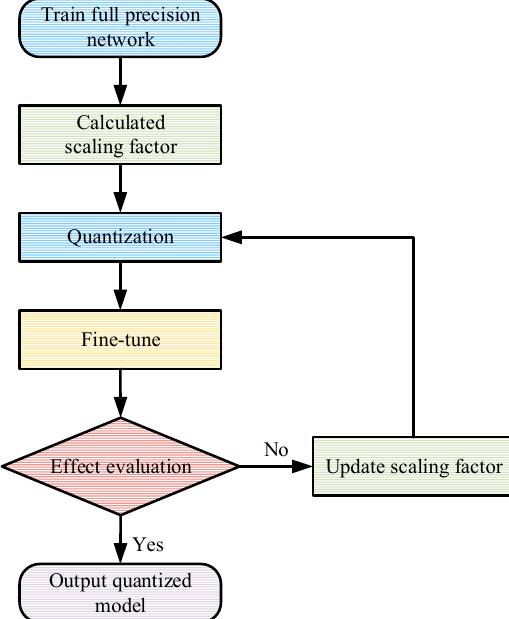
Figure 6. Parametric quantization flow chart.